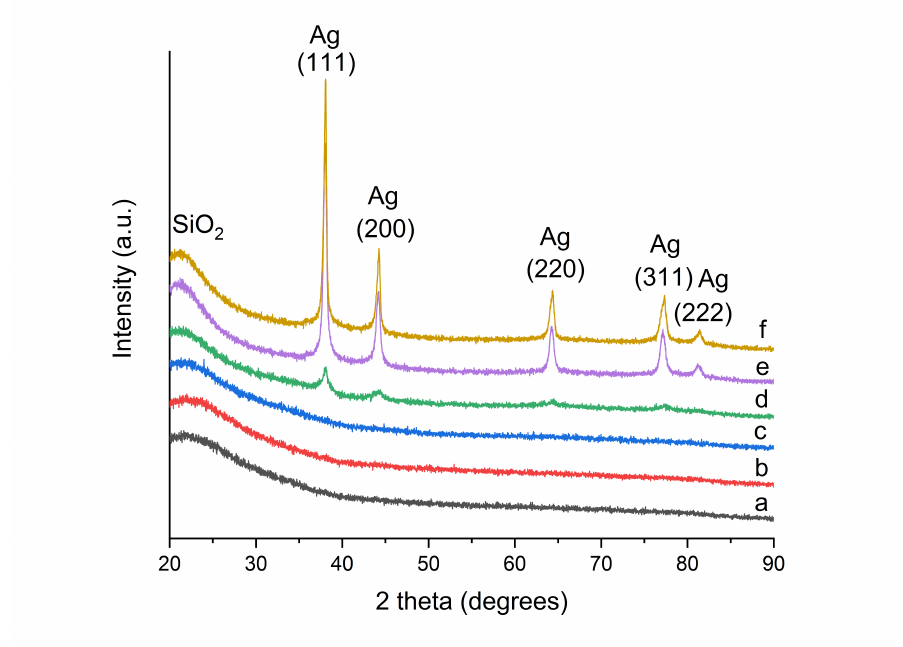
Figure 2. X-ray diffraction patterns of SiO 2 –Ag powders heat treated at ( a ) 300 ◦ C; ( b ) 400 ◦ C; ( c ) 500 ◦ C;